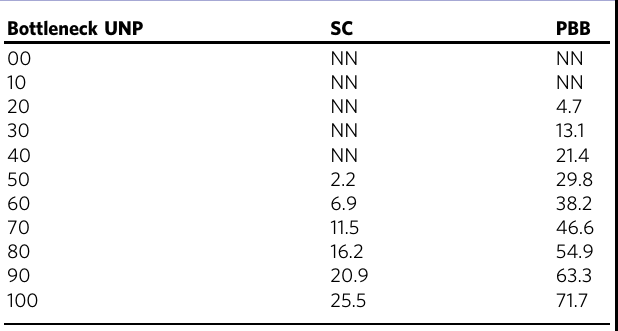
CR-FDH bottleneck table. NN not